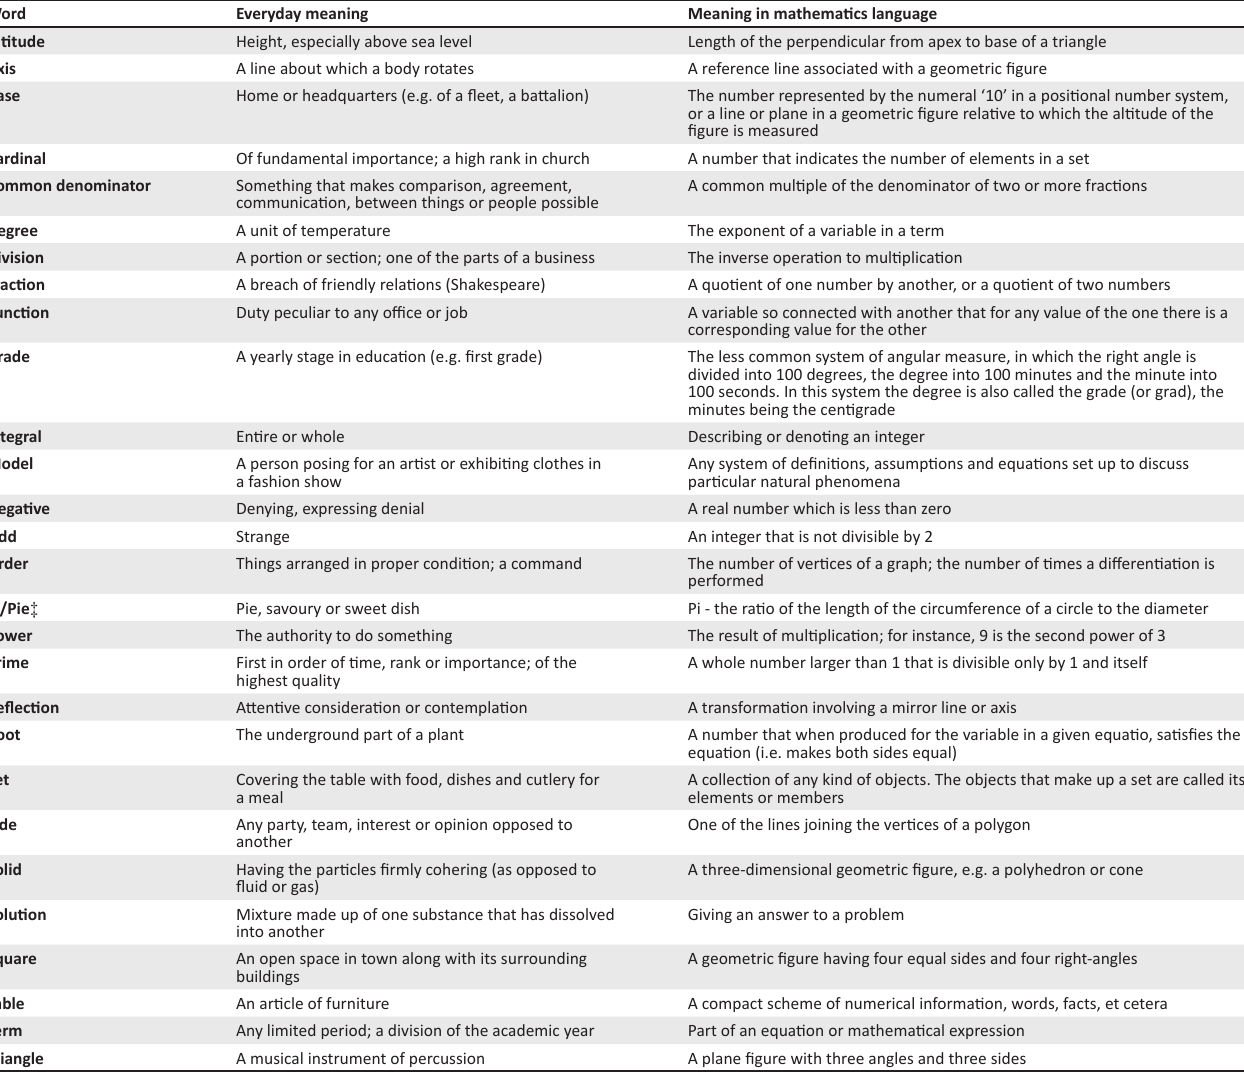
TABLE 1: Examples from the ‘double-meaning words bank’ of the pre-service teachers.